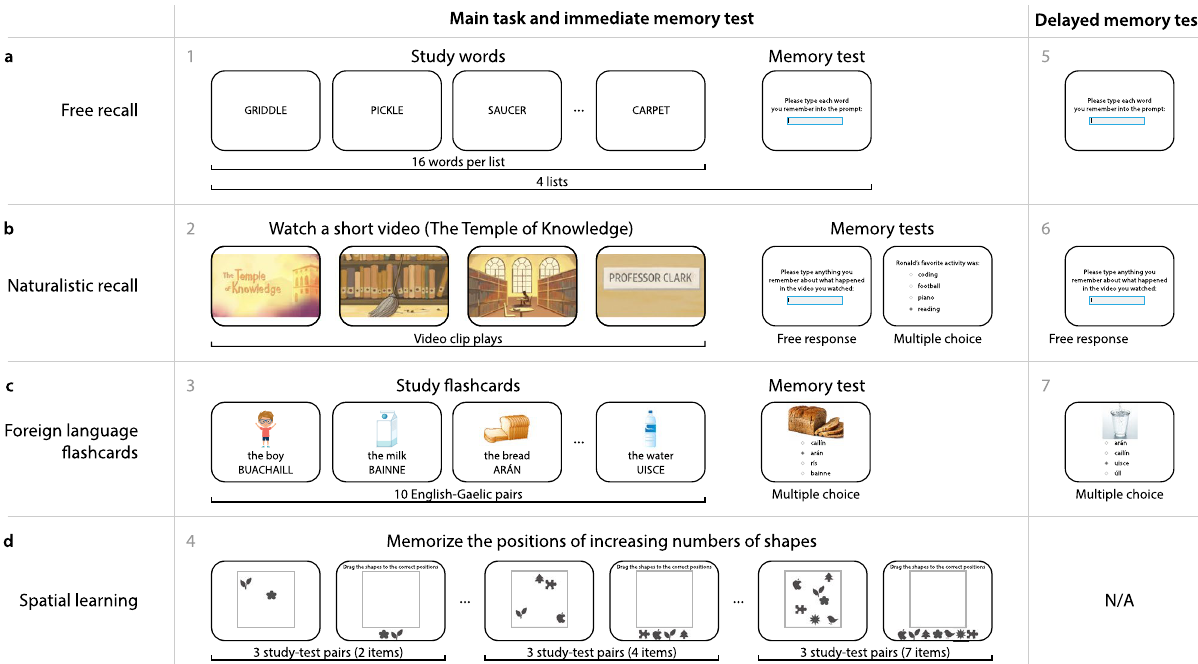
Figure 1. Battery of memory tasks. ( a ) Free recall. Participants study 16 words (presented one at a time), followed by an immediate memory test where they type each word they remember from the just-studied list. In the delayed memory test, participants type any words they remember studying, from any list. ( b ) Naturalistic recall. Participants watch a brief video, followed by two immediate memory tests. The first test asks participants to write out what happened in the video. The second test has participants answer a series of multiple choice questions about the conceptual content of the video. In the delayed memory test, participants (again) write out what happened in the video. ( c ) Foreign language flashcards. Participants study a sequence of 10 English- Gaelic word pairs, each presented with an illustration of the given word. During an immediate memory test, participants perform a multiple choice test where they select the Gaelic word that corresponds to the given photograph. During the delayed memory test, participants perform a second multiple choice test, where they select the Gaelic word that corresponds to each of a new set of photographs. ( d ) Spatial learning. In each trial, participants study a set of randomly positioned shapes. Next, the shapes’ positions are altered, and participants are asked to drag the shapes back to their previous positions. All panels. The gray numbers denote the order in which participants experienced each task or